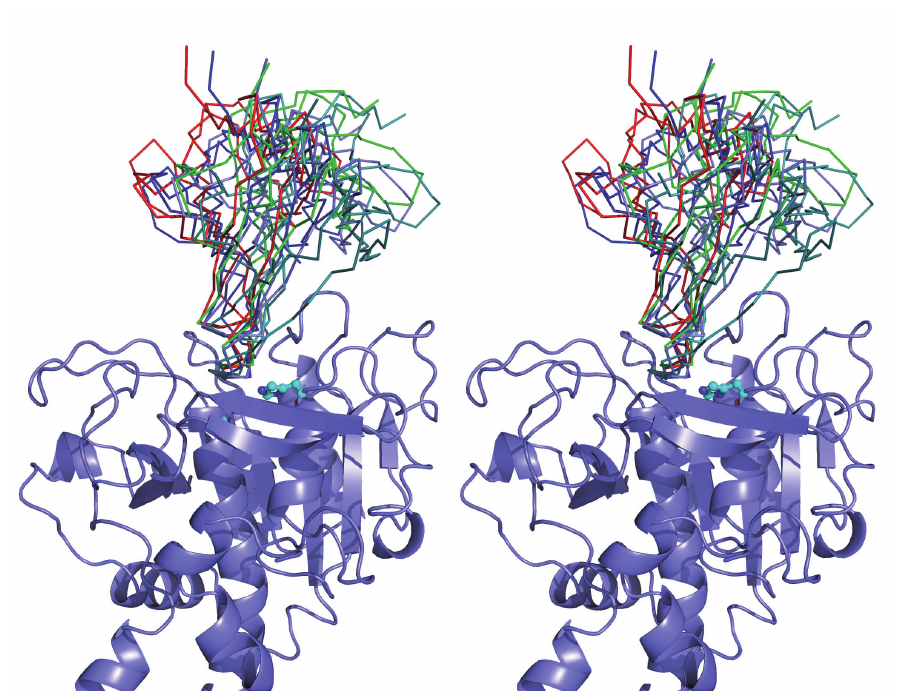
Supplementary figure 1. Stereo view of the superposition of docking poses from ZDOCK (numbers 1, 4 and 5, coloured shades of blue), GRAMM-X (number 2, coloured red) and ClusPro (number 3, coloured green) showing broadly similar modes of inhibitor interaction with the enzyme, shown as cartoon below with catalytic triad drawn in